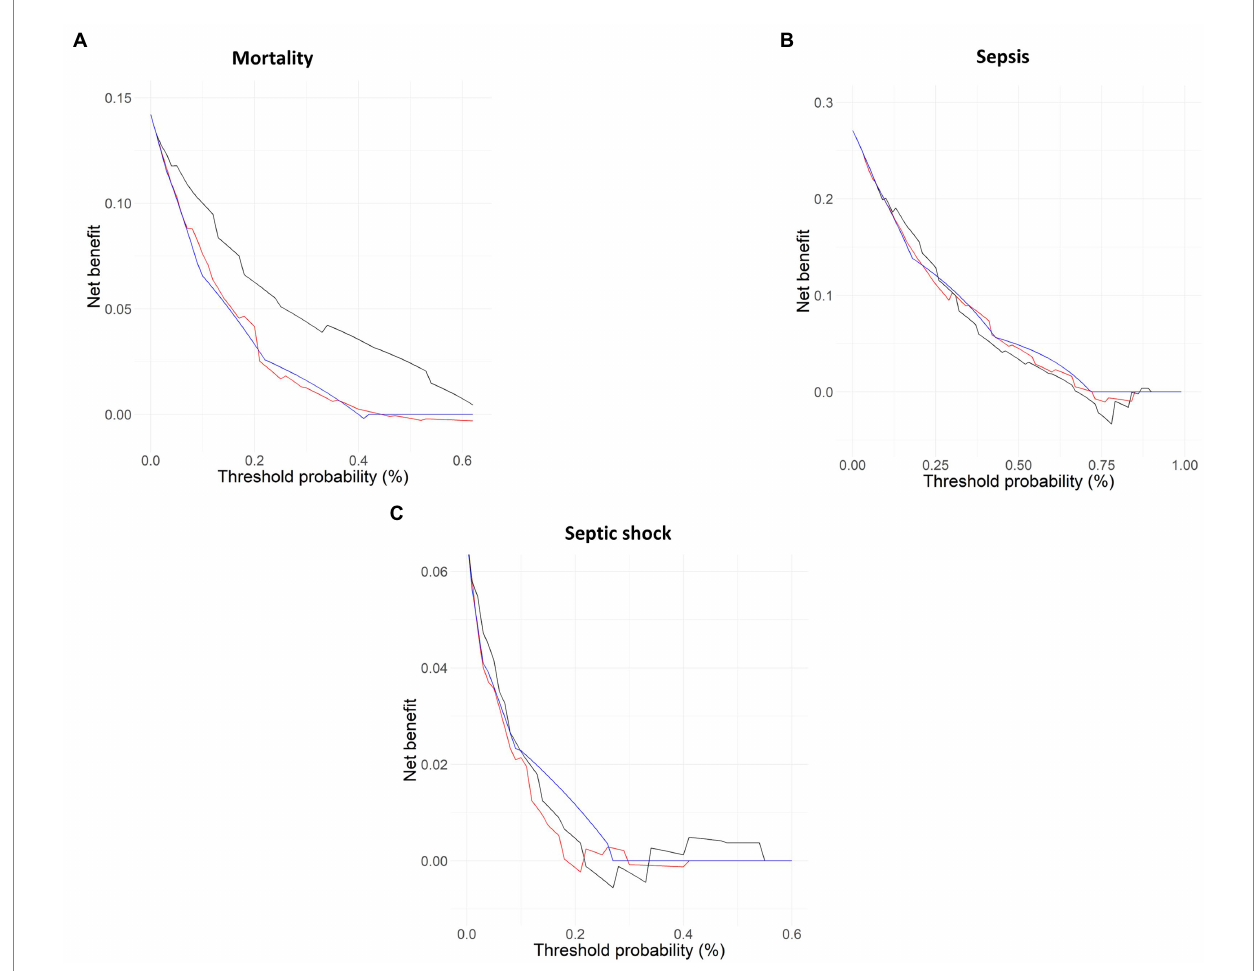
FIGURE 4 Decision curve analysis for each model. Solid line shows the decision (ROC) curve for mortality (A) , sepsis (B) , and septic shock (C) . black line = mSOFA, red line = NEWS2, blue lines =